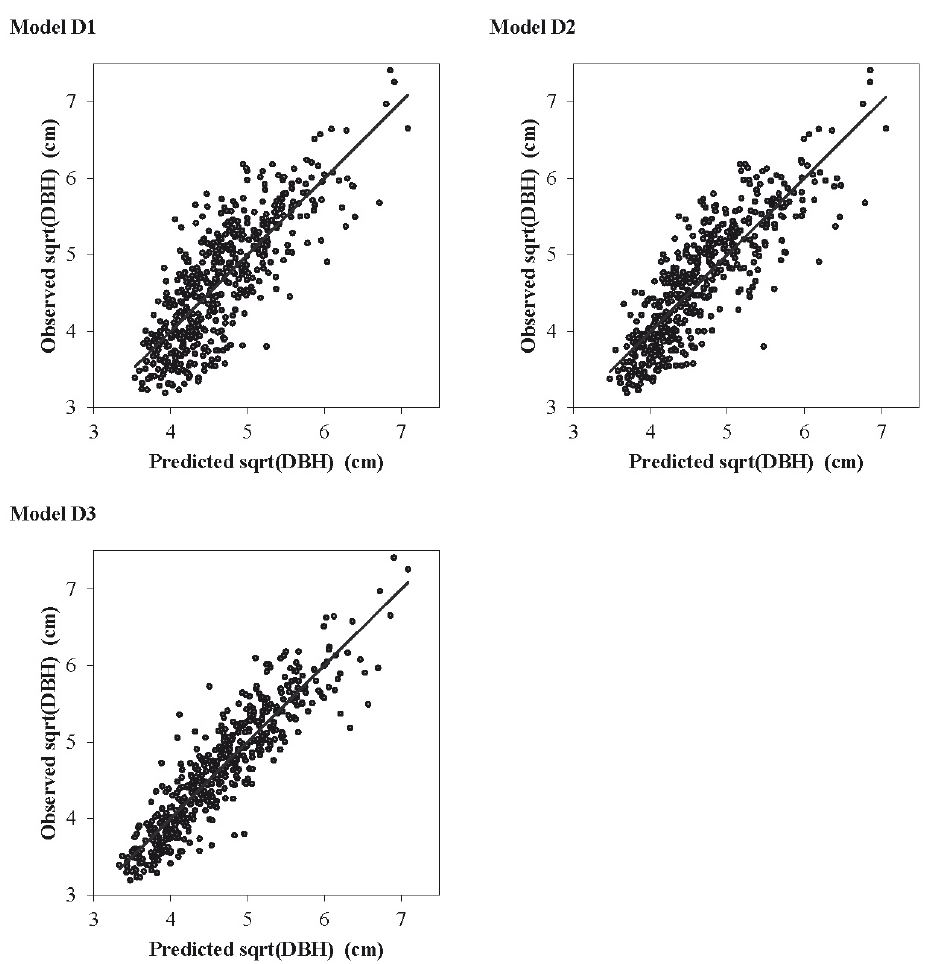
Figure 2. Predicted vs. observed diameter at breast height (DBH) for three selected black pine DBH models. The solid line represents fitted linear model. Models’ description and evaluation statistic are presented in Table